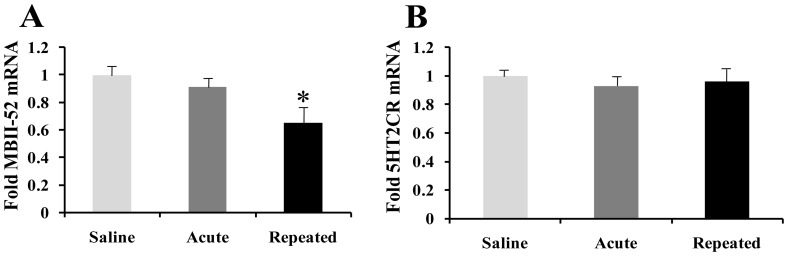
Transcriptional regulation of MBII-52 and 5HT2CR by chronic cocaine in NAc.Repeated cocaine administration, but not acute, significantly decreased MBII-52 (A) and not 5HT2CR (B) mRNA in NAc 24 h after the final drug injection compared with saline treatments (n = 6 mice per group; *p<0.05).